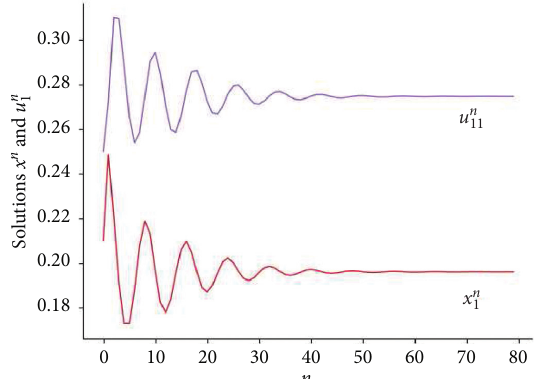
Figure 3: Dynamic behaviors of x n (37) with initial conditions ( 0 . 16 , 0 . 21 , 0 . 16 , 0 . 21 , 0 . 21 , 0 . 26 , 0 . 21 , 0 . 26 , 0 . 25 , 0 . 22 , 0 . 45 , 0 . 50 ) when d